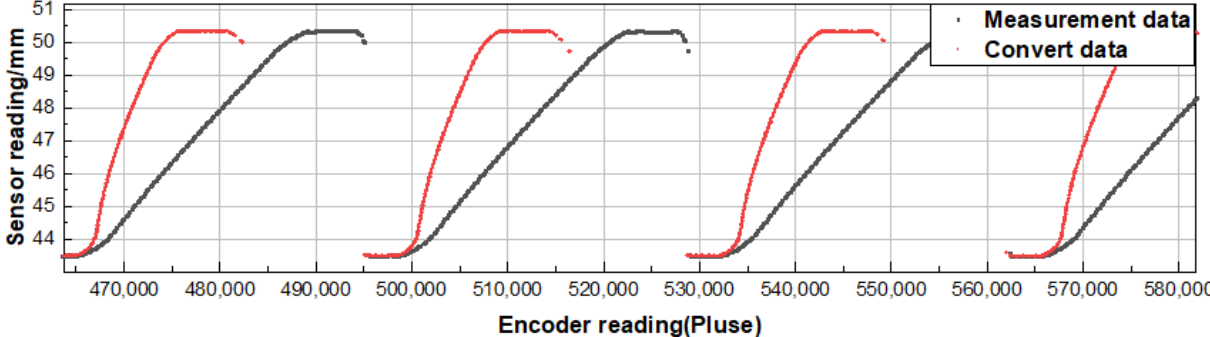
Figure 11. Coordinate conversion result with an offset value of 23.